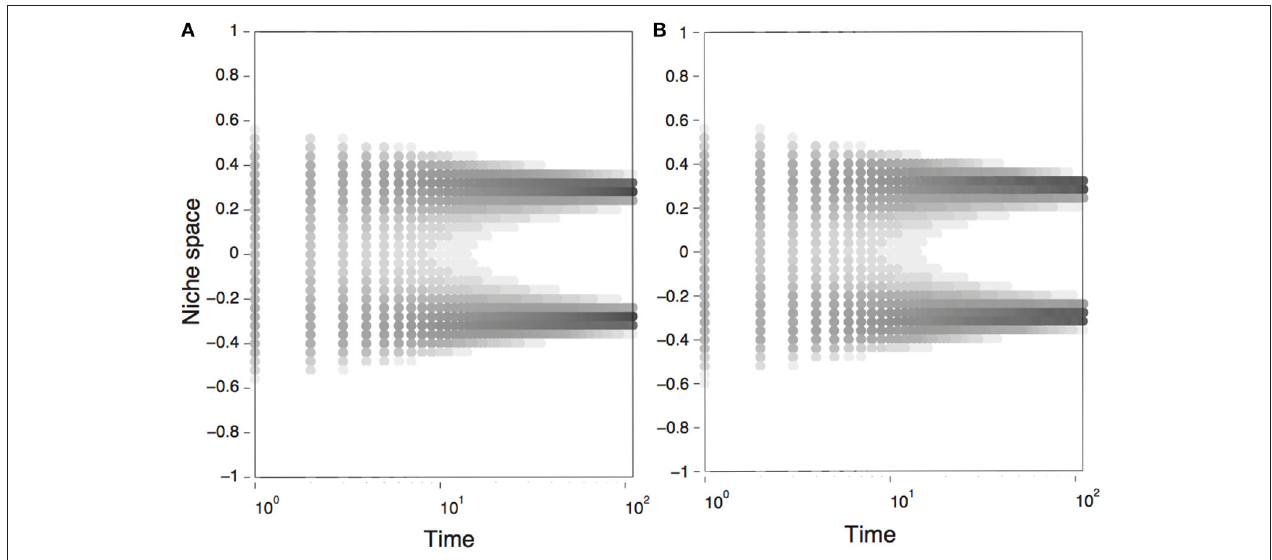
FIGURE 2 | Dynamics of the Lotka-Volterra Competition models studied in this work. Panels show the temporal dynamics, obtained by numerical simulations, of a population using the marginalized model (A) , defined by Equations (8–9); and the stochastic model (B) , defined by Equations (1, 4–6). As initial conditions we used a bell–shaped distribution of phenotypes ( φ ( x ,0) n k function ( n α 2.0); and a regime of frequency-dependent selection. Parameters were: r = =